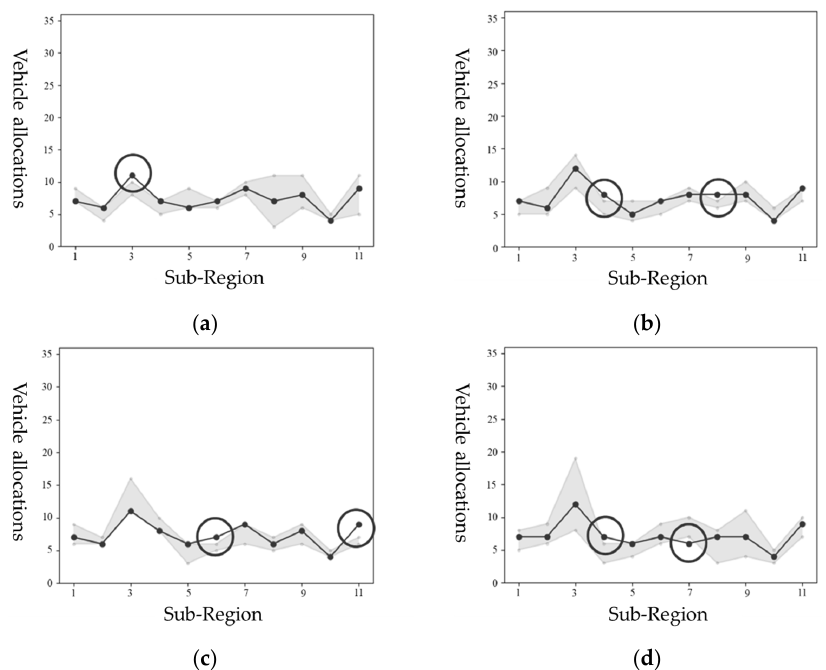
Figure 15. Arena vs. GAN’s Station-Car results in first four cases where gray shaded area covers lower and upper bounds of each case, solid lines are vehicle allocations from GAN, and open circles indicate the sub-region where the number of vehicles identified by GAN did not fall within the range produced by Arena: ( a ) Case 1, ( b ) Case 2, ( c ) Case 3, ( d ) Case